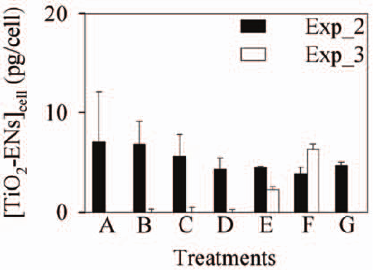
Figure 4. Accumulation of TiO 2 -ENs ([TiO 2 -ENs] cell , pg/cell) by Chlamydomonas reinhardtii in the different treatments of the second (Exp_2) and third (Exp_3) toxicity experiments. In Exp_2, treatment A–G indicates different initial concentrations of Cd 2 + (0, 0.1, 0.3, 0.5, 0.8, 1.0, and 3.0 mg/l) with the TiO 2 -EN concentration fixed at 100 mg/l. In Exp_3, the initial Cd 2 + concentration was fixed at 1 mg/l and various concentrations (0, 1, 3, 10, 30, and 100 mg/l) TiO 2 -ENs were used for treatments A–F. Data are mean 6 standard deviation (n=2).